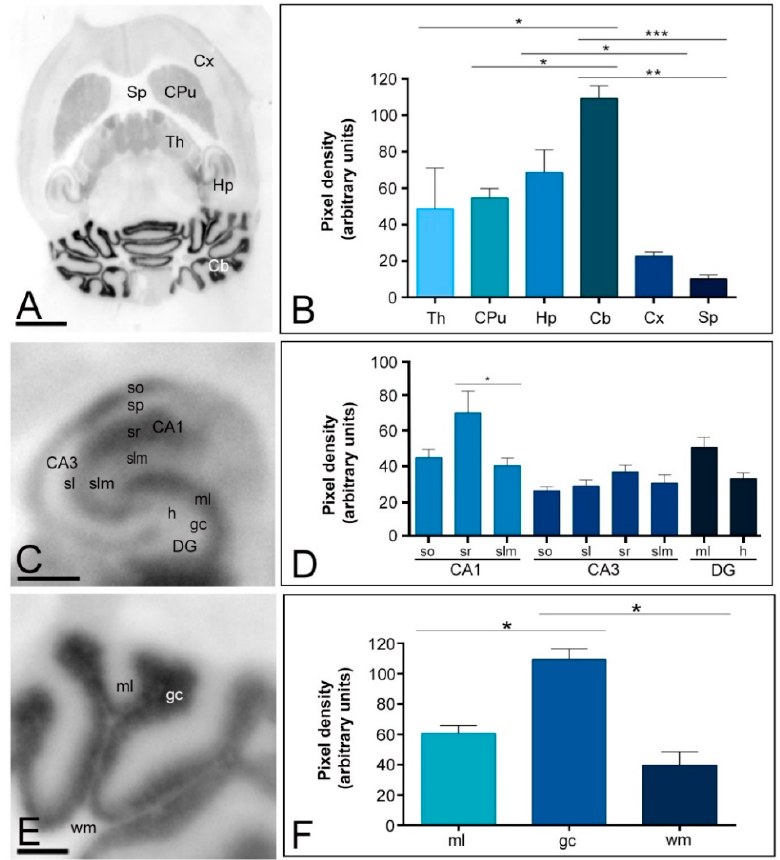
Figure 1. Regional distribution of the Kv4.2 channel in the adult mouse brain. ( A , B ) The distribution of the Kv4.2 protein was visualised in histoblots of horizontal brain sections at P60 using an affinity-purified anti-Kv4.2 antibody. The expression of Kv4.2 in different brain regions was determined by densitometric analysis of the scanned histoblots. The strongest expression was detected in the cerebellum (Cb) and hippocampus (Hp), with moderate expression in the caudate putamen (CPu) and thalamus (Th). Weak expression level was detected in the cortex (Cx) and septum (Sp); ( C , D ) In the hippocampus, very strong Kv4.2 expression was detected in the strata oriens (so) and radiatum (sr) of the CA1 region and the molecular layer (ml) of the dentate gyrus (DG); ( C , D ) Moderate staining was observed in all dendritic layers of CA3, in the stratum lacunosum-moleculare (slm) of the CA1 region and the hilus of the dentate gyrus. Very weak Kv4.2 staining was observed in the stratum pyramidale of the CA1 and CA3 regions and in the granule cell layer of the dentate gyrusso, stratum oriens ; sr, stratum radiatum ; DG, dentate gyrus; h, hilus .; ( E , F ) In the cerebellum, the strongest expression level was detected in the granule cell layer (gc), with weak expression in the molecular layer (ml) and very weak in the white matter (wm). Error bars indicate SEM; * p < 0.05; ** p < 0.01; *** p < 0.001. Scale bars: A, 1 mm; C and E, 0.5 mm.